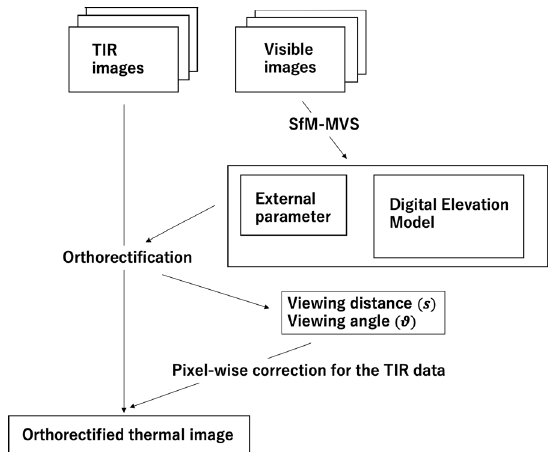
Fig. 3 Workflow of the proposed method SfM–MVS is applied to the visible images to generate DEM. Exterior parameters are estimated in the SfM–MVS at the same time. The TIR images are orthorectified using the DEM and exterior parameters. Through orthorectification, the viewing distance and angle can be obtained for each pixel. These parameters are used to perform a pixelwise correction of the TIR images